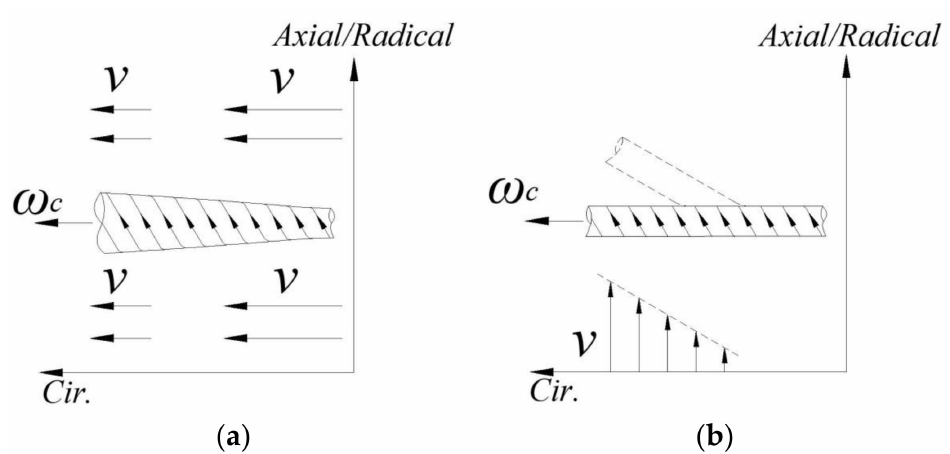
Figure 17. Deformation of the vortex caused by velocity gradients. ( a ) Vortex stretching term; ( b ) Vortex bending term.